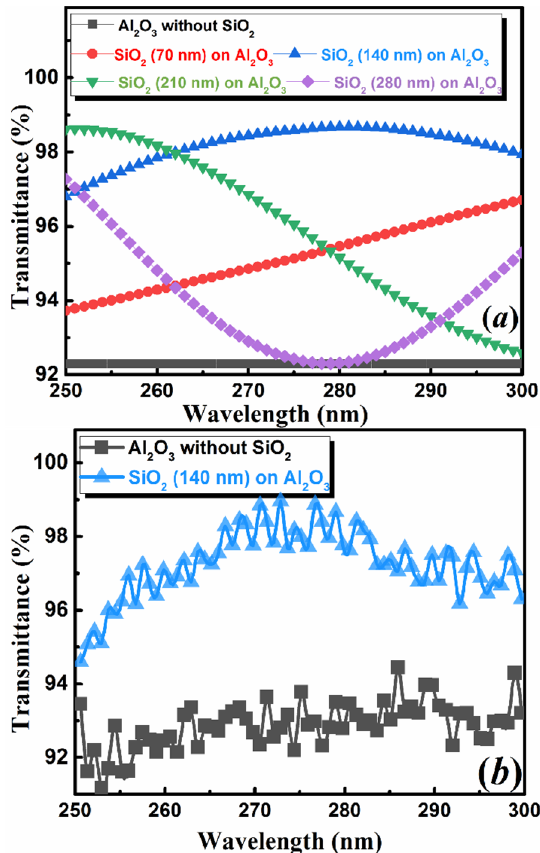
Figure 4. Transmittance of SiO 2 antireflective film: ( a ) simulated transmittance (Angle = 0°) of SiO 2 /Al 2 O 3 structure with different SiO 2 thicknesses; ( b ) experimental transmittance (Angle = 0°) of SiO 2 /Al 2 O 3 structure with 140 nm SiO 2 .